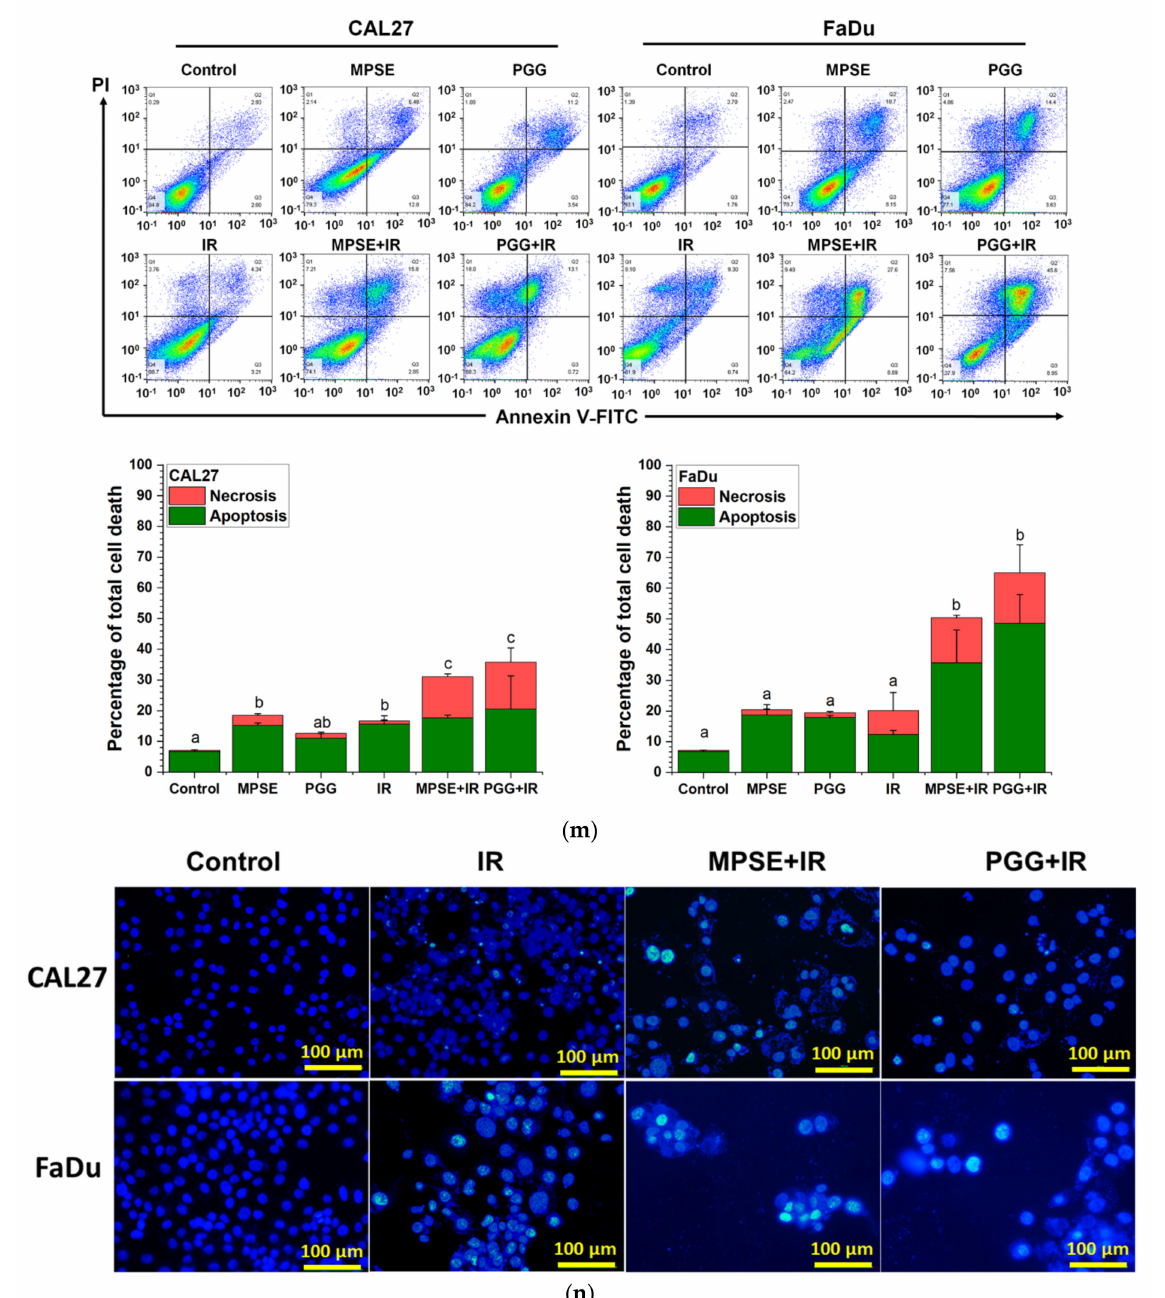
Figure 5. MPSE or PGG enhanced IR-induced DNA damage and cell death in HNSCC cell lines. ( a ) Representative images of γ H2AX foci by immunofluorescence staining with antibodies against γ H2AX for different treatments. ( b , c ) Quantification of γ H2AX foci in ( b ) CAL27 or ( c ) FaDu cells treated with IR alone or combination of 15 µ g/mL MPSE or PGG with IR. Data obtained from >100 cells (circles), numbers in the graph represent the mean of each group. ( d ) The protein expression levels of DNA damage response markers, including phosphorylated γ H2AX and p53 were determined by Western blot analysis in the indicated groups. ( e , f ) The immunoblot signal intensities were quantified by densitometry; relative band intensity was normalized to the band intensity of GAPDH. ( g ) CAL27 and FaDu cells were treated as indicated. After 48 h, expression levels of phospho-Akt, phospho-ERK1/2, Akt, ERK, cleaved PARP, cleaved caspase3, Bax, and